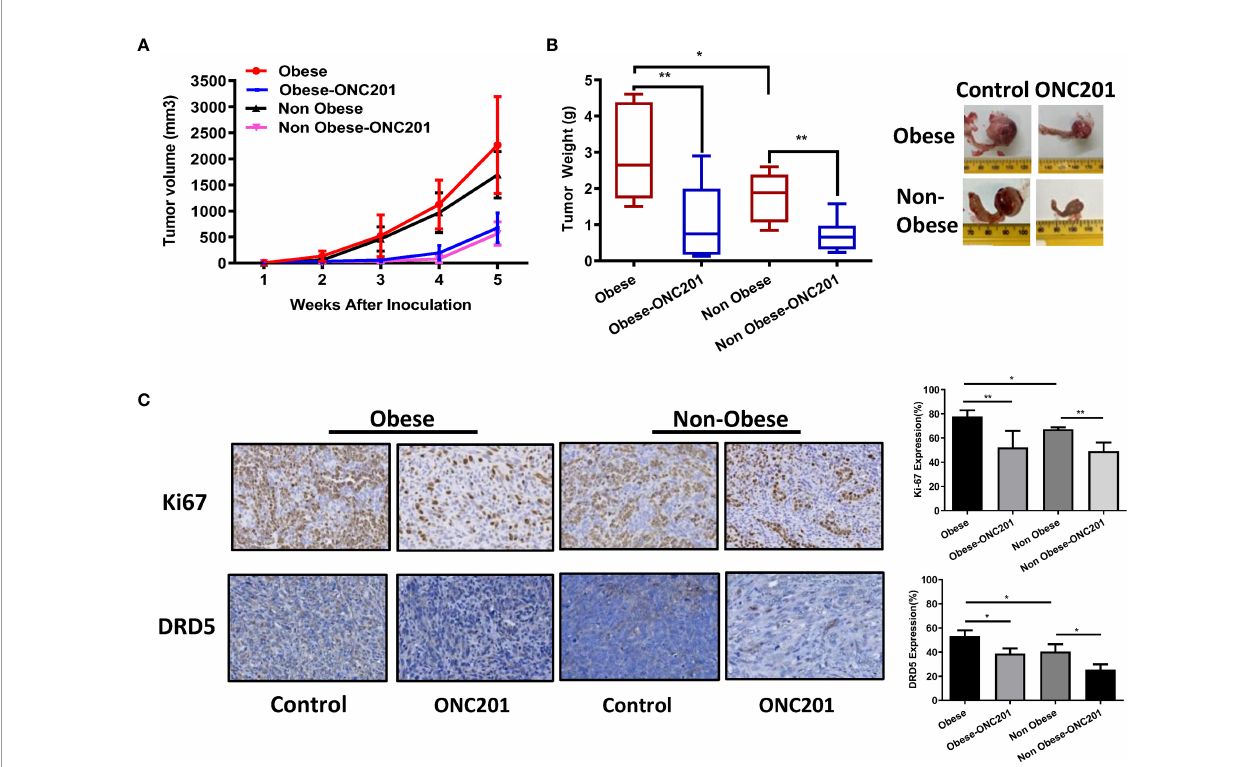
FIGURE 4 | ONC201 inhibited tumor growth in KpB mouse model of OC. Obese or lean KpB mice were treated with ONC201 (130 mg/kg, weekly) or vehicle for 4 weeks. Tumor volumes of ovarian tumors were measured weekly. The mean tumor volume was reduced in obese or lean mice treated with ONC201 (A) . Tumor weight measurements of KpB mice were recorded at the time of sacri fi ce (B) . The expression of DRD5 and Ki67 was assessed by immunohistochemistry analysis in ovarian tumors following ONC201 treatment. The results showed that ONC201 decreased the expression of Ki-67 and DRD5 in the ovarian tumor tissues under obese and lean conditions (C) . *p < 0.05; **p <